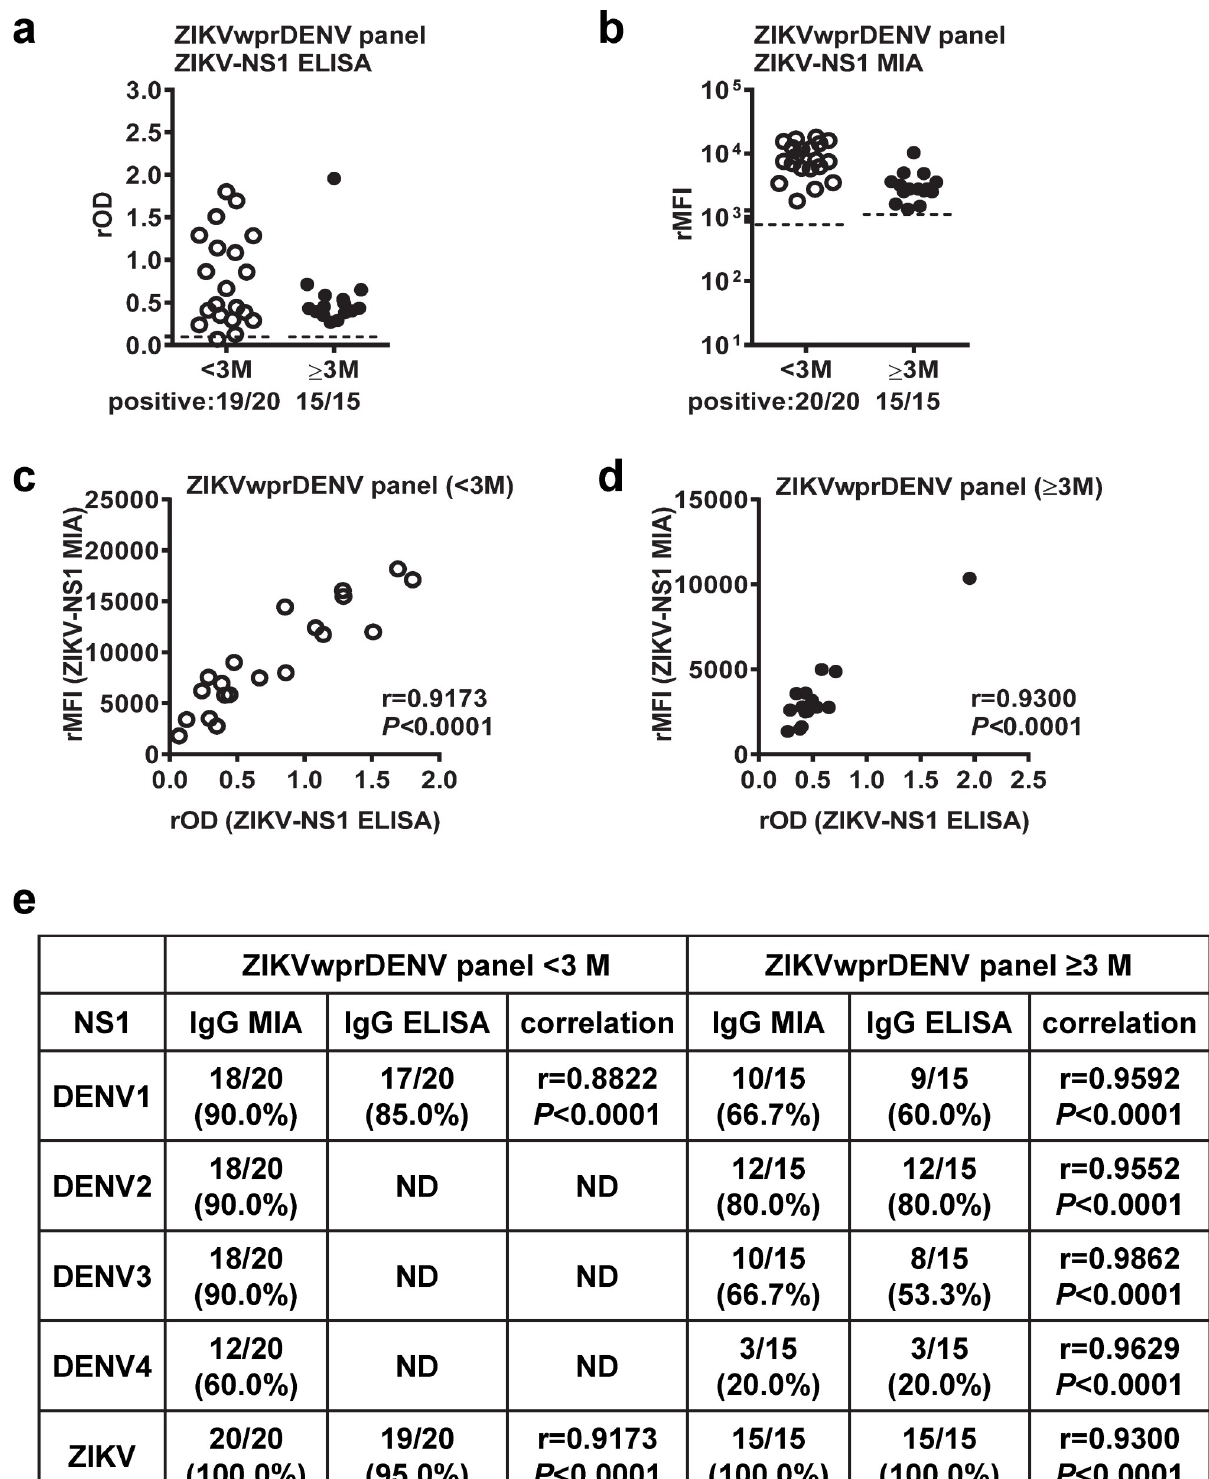
Fig 4. Comparison between NS1 IgG MIA and ELISA for ZIKVwprDENV panel. (a-d) The results of ZIKV NS1 IgG ELISA (a) and MIA (b) for convalescent- and post-convalescent-phase samples. Relationship between rOD and rMFI values for the convalescent-phase (c) and post-convalescent- phase (d) samples. Data are the means of two experiments (each in duplicate). Dashed lines indicate cutoff rOD or rMFI. The two-tailed Spearman correlation test was performed; r, correlation coefficient. (e) Summary of the relationship between rOD and rMFI values of different NS1 IgG ELISAs and MIAs for the convalescent-phase and post-convalescent-phase samples of ZIKVwprDENV panel.